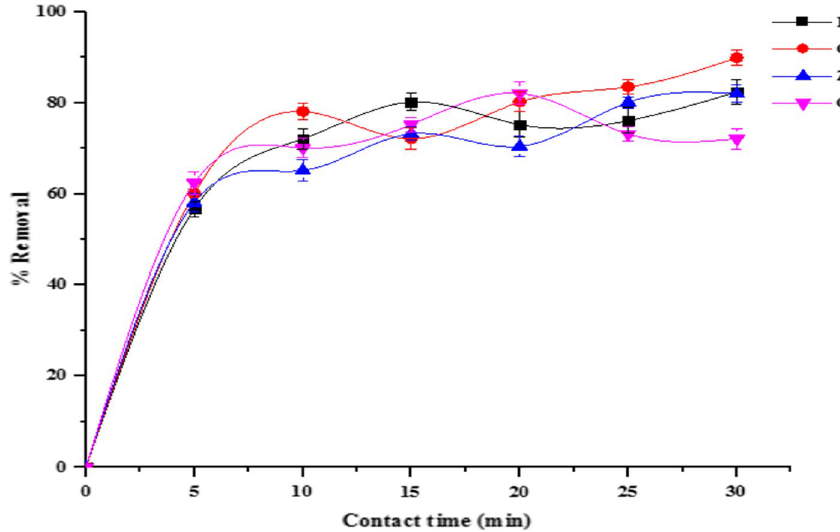
Fig. 4 Effect of contact time